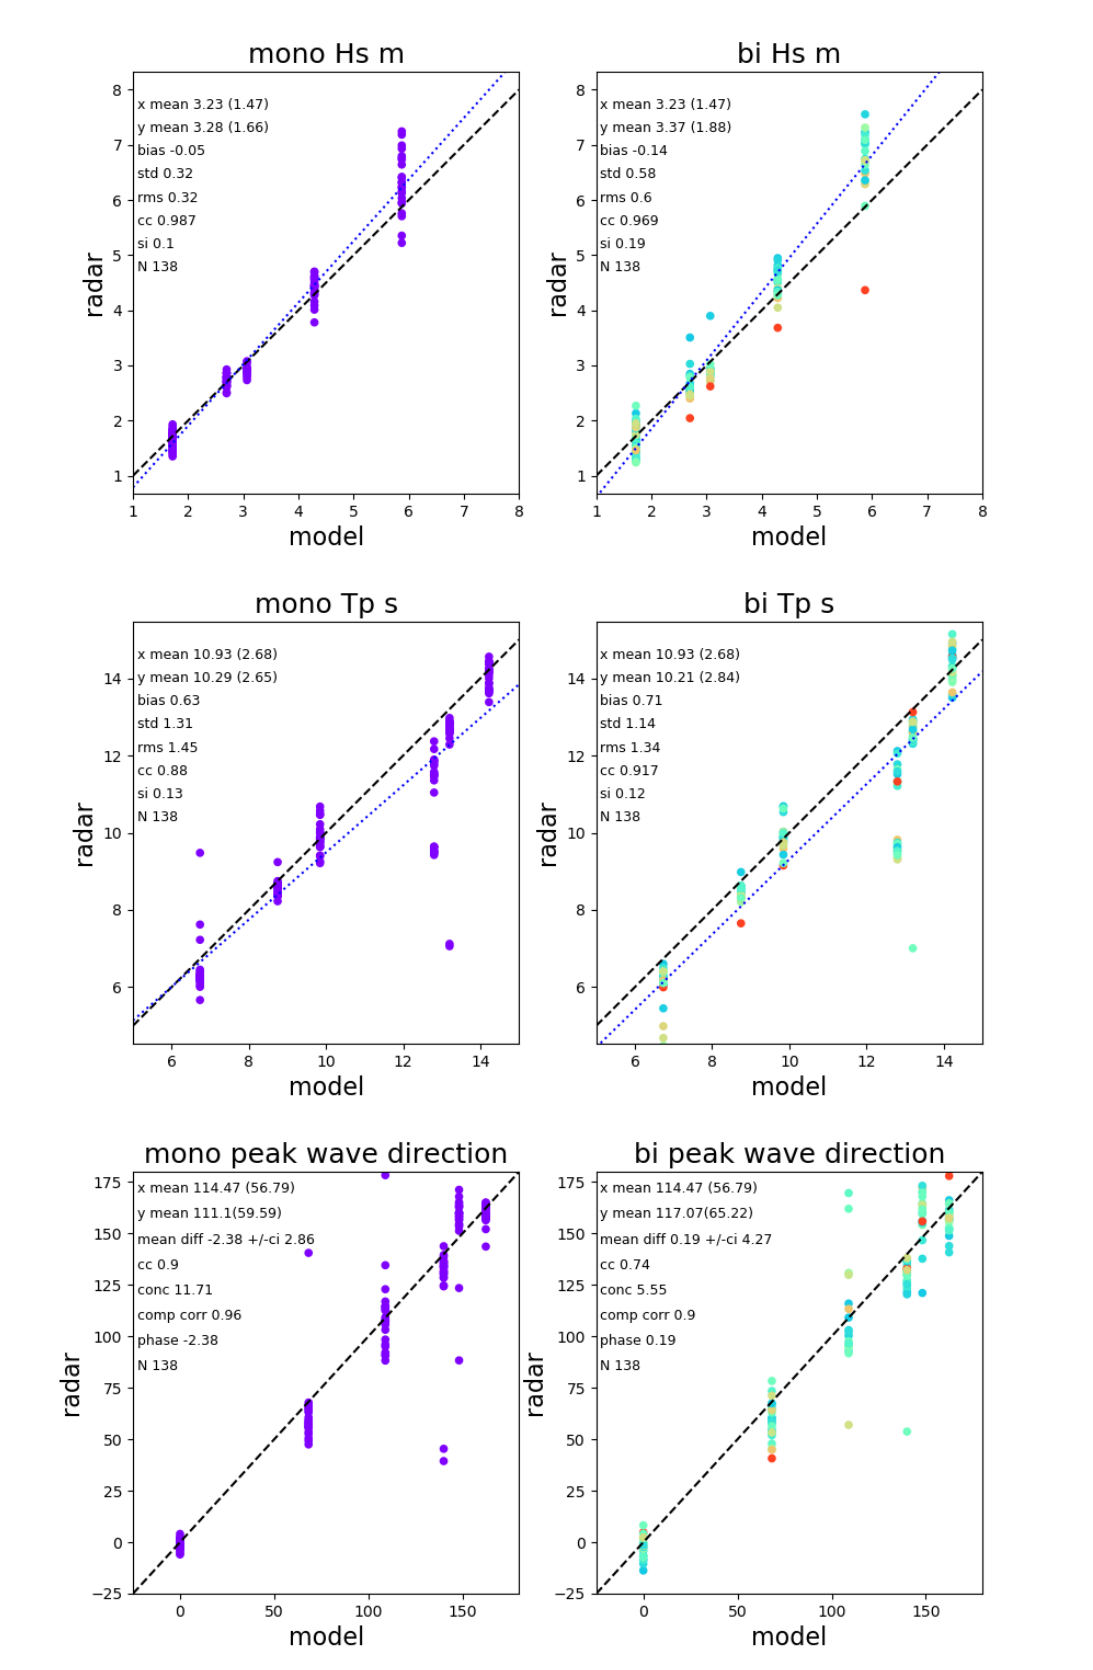
Figure 23. Scatter plots and statistics of the wave parameter measurements, colour-coded with the bistatic